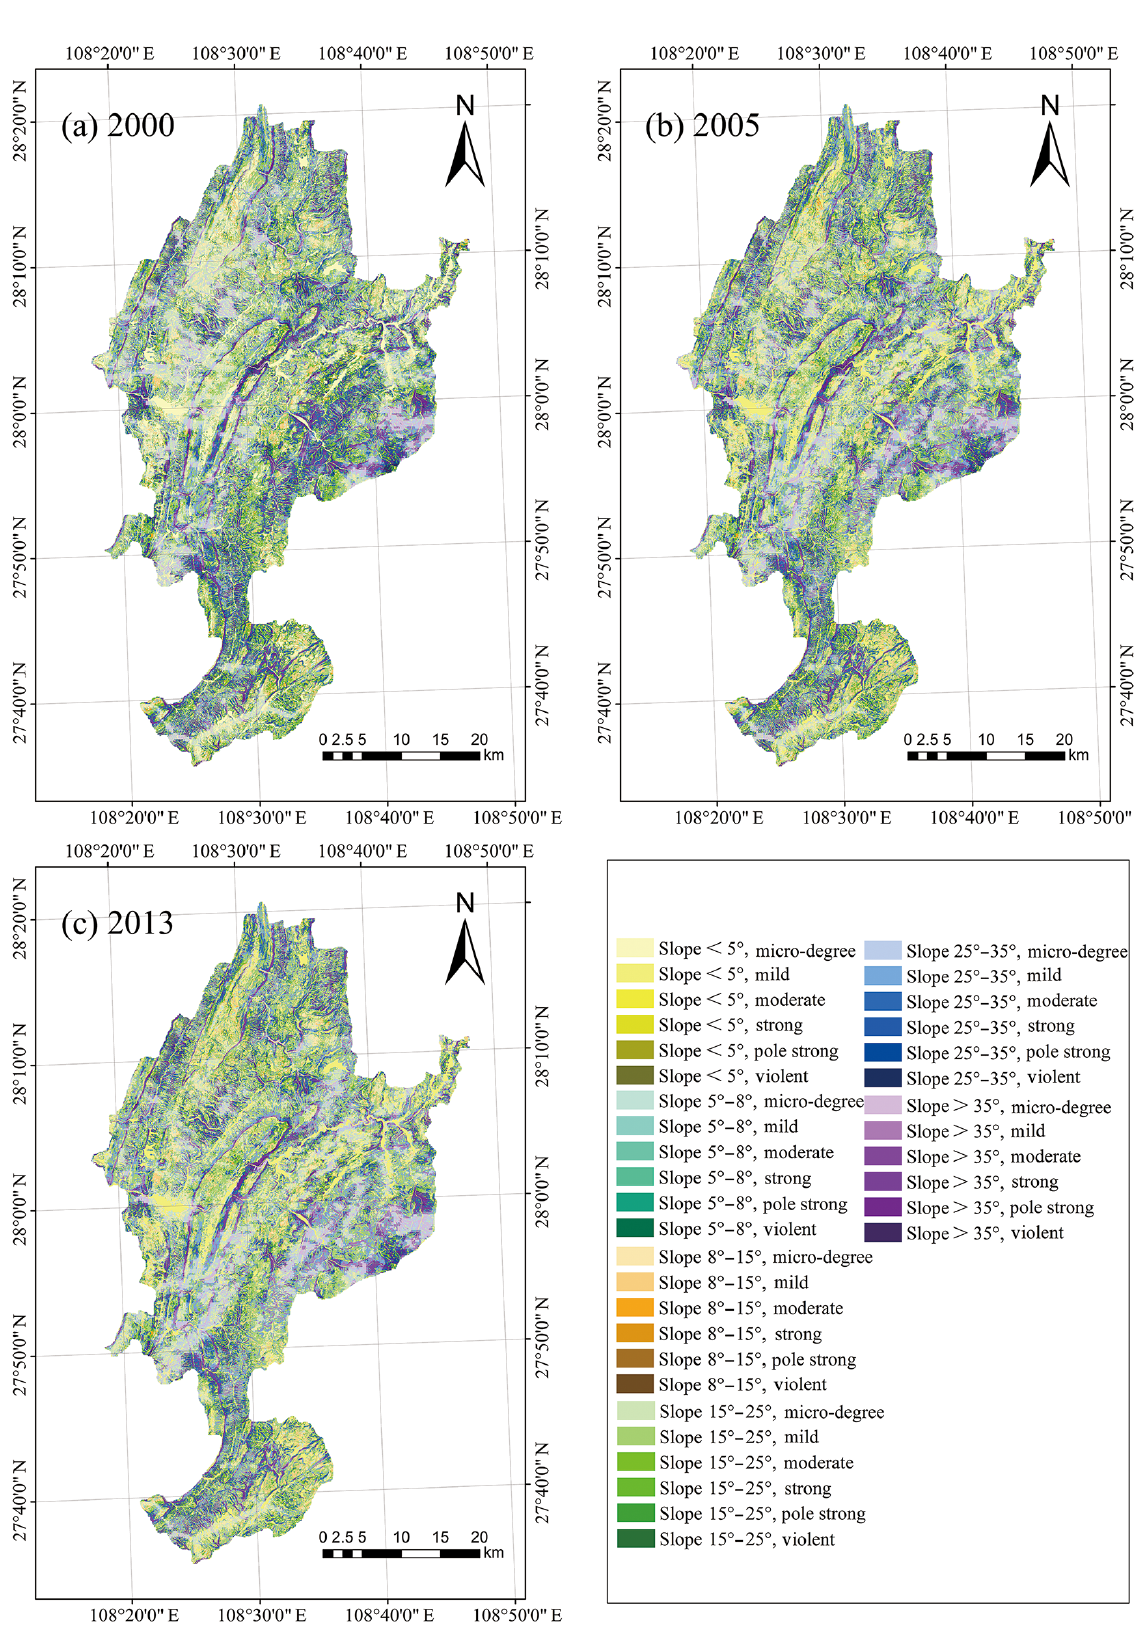
Figure 6. Spatial distribution of soil erosion in different slope